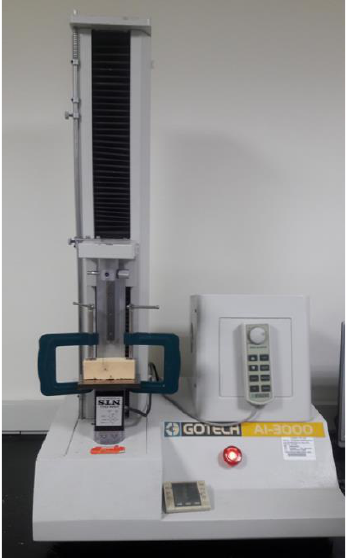
Figure 6. An orthodontic wire (0.018 inch) was passed through the hole of microimplant, then tied wan).